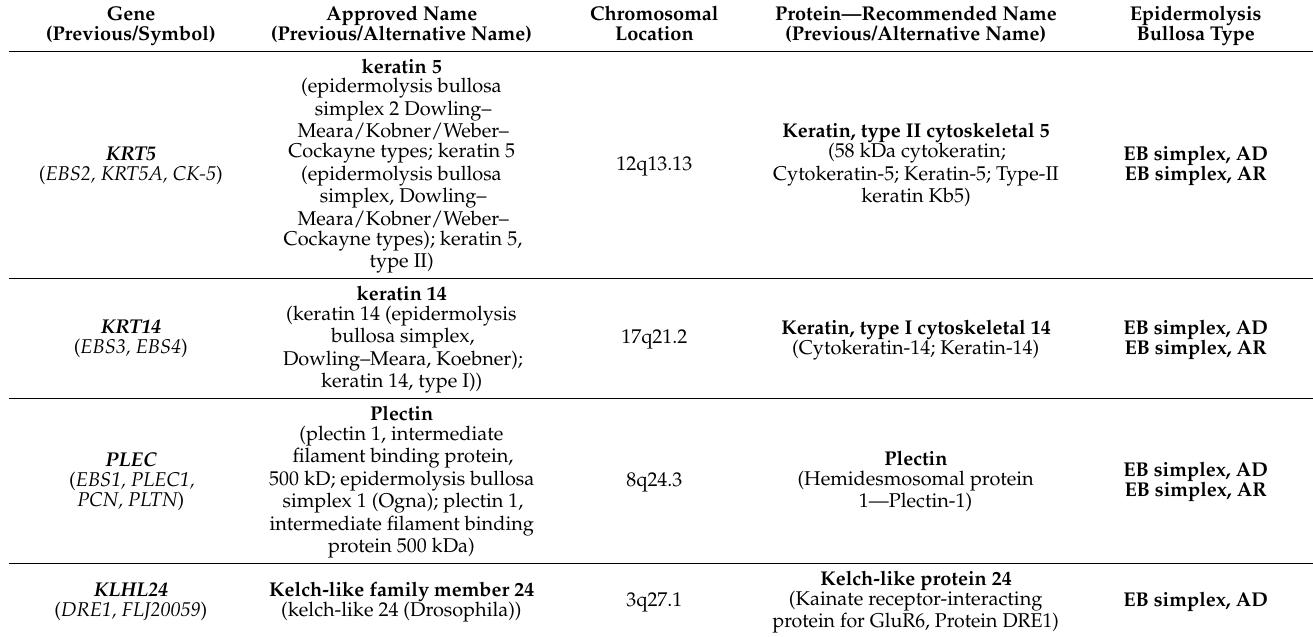
Table 1. Genes and proteins involved in epidermolysis bullosa